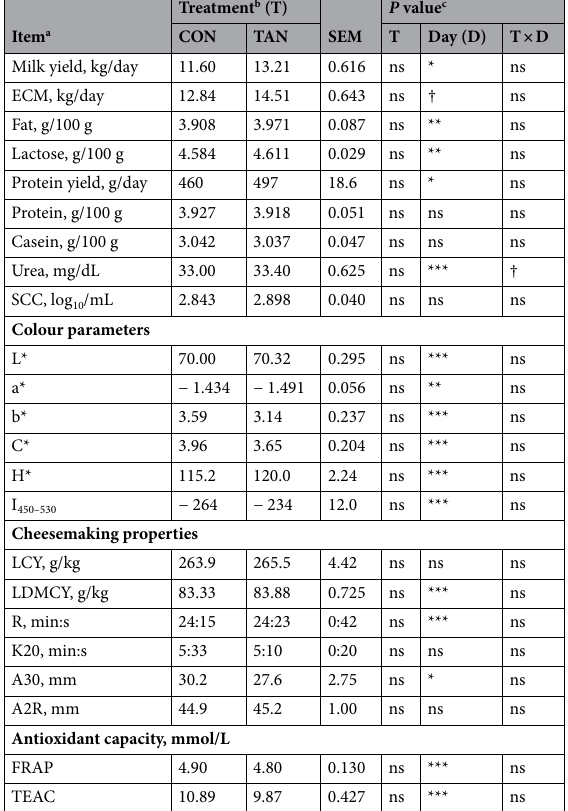
Table 2. Effect of dietary tannin extract on physicochemical properties of milk in wet season experiment. a L* lightness, a* redness, b* yellowness, C* chroma, H* hue angle, I 450–530 integral value of the absorbance spectrum from 450 to 530 nm, LCY laboratory cheese yield, LDMCY laboratory dry matter cheese yield, R clotting time, K20 firming time, A30 curd firmness after 30 min, A2R curd firmness after two times R, FRAP ferric reducing antioxidant power, TEAC Trolox-equivalent antioxidant capacity, ECM energy corrected milk, SCC somatic cells count. b CON control group, TAN group receiving 150 g/head × day of tannin extract. c ns ≥ 0.100; † <